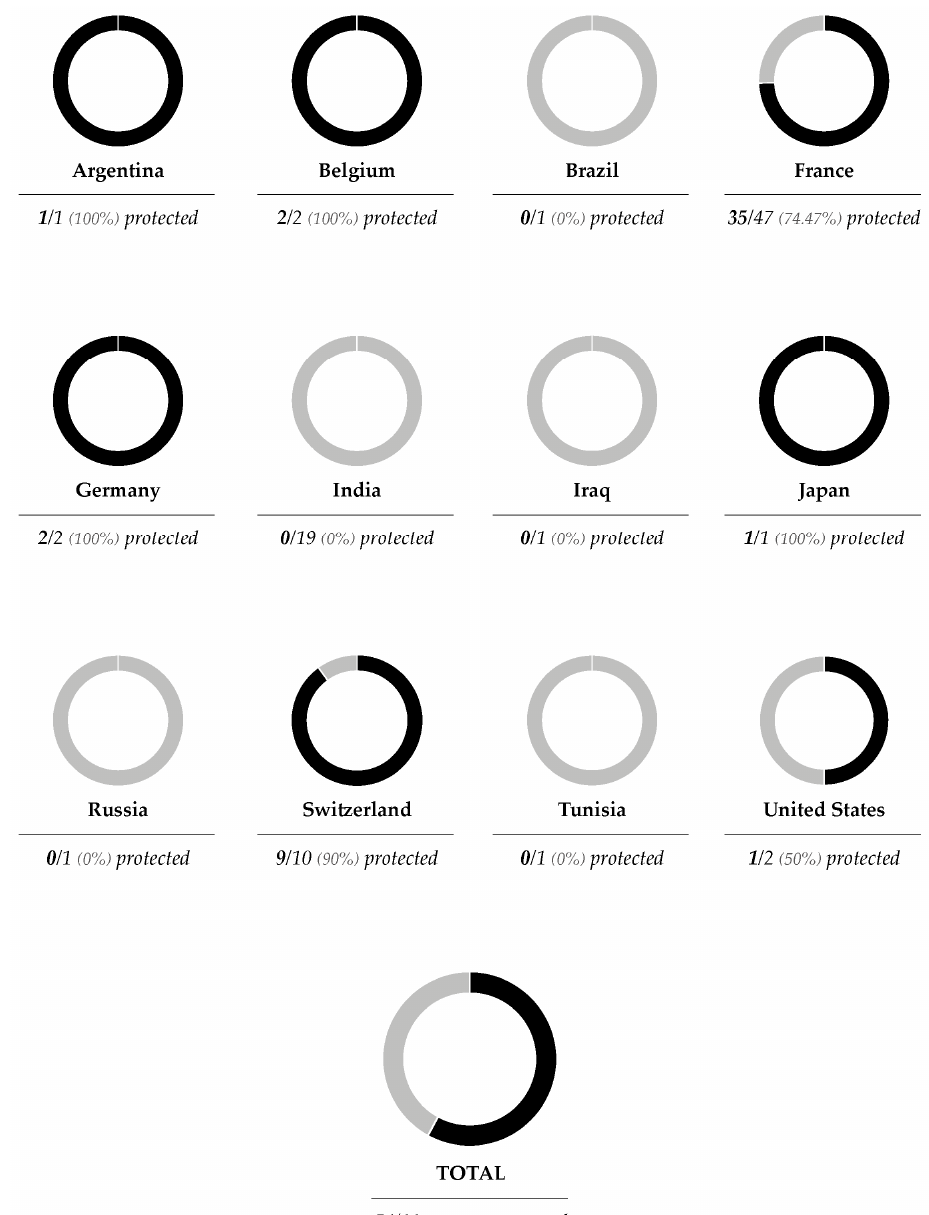
Figure 1. Graphics with total number and percentage of construction sites and buildings that have been heritage listed by country. Source: Authors.